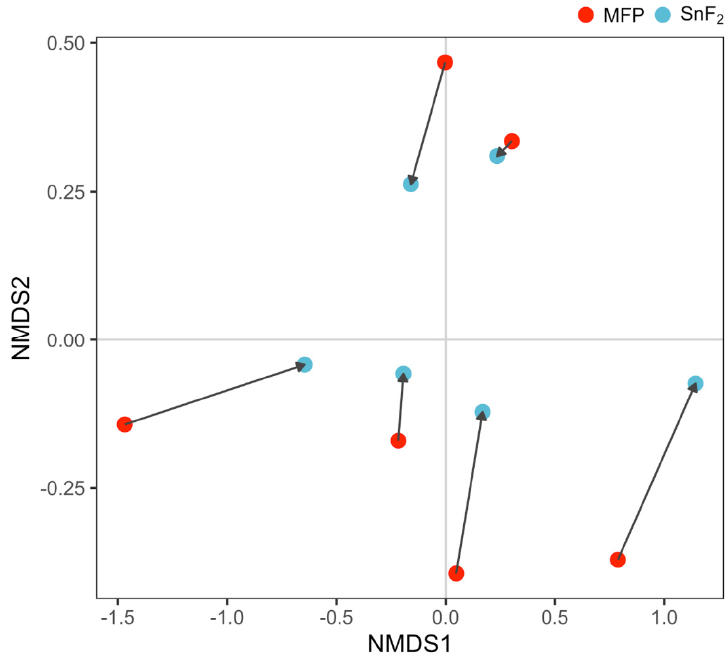
Figure 7. Non-metric multidimensional scaling (NMDS) plot showing distribution of panelists based on Bray–Curtis dissimilarity matrix calculated from TMM normalized transcript count estimates. Sodium monofluorophosphate (MFP) and SnF 2 samples from the same panelist are connected by an arrow. Differential gene expression of KOs between control and SnF 2 groups and for indi- vidual panelists is visualized in volcano plots (Figure 8 and Supplementary Materials Figure S2, respectively). Of the 7734 KOs, 71 were significantly differentially expressed with a probability cutoff of 0.8 without biological replicates; 68 were higher in control, and 3 were higher in the SnF 2 group (Figure 8). Further analysis of the gene expression revealed pathway and gene level patterns which reflected the reaction of the microbiome to SnF 2 .